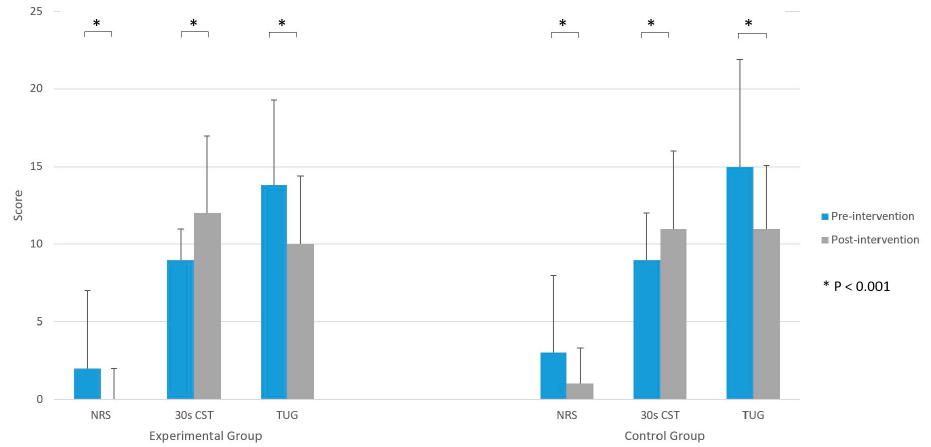
Figure 4. Numeric rating scale (NRS), 30 s chair stand test (CST), and timed up and go test (TUG) scores pre-intervention (day 1) and post-intervention (day 21).